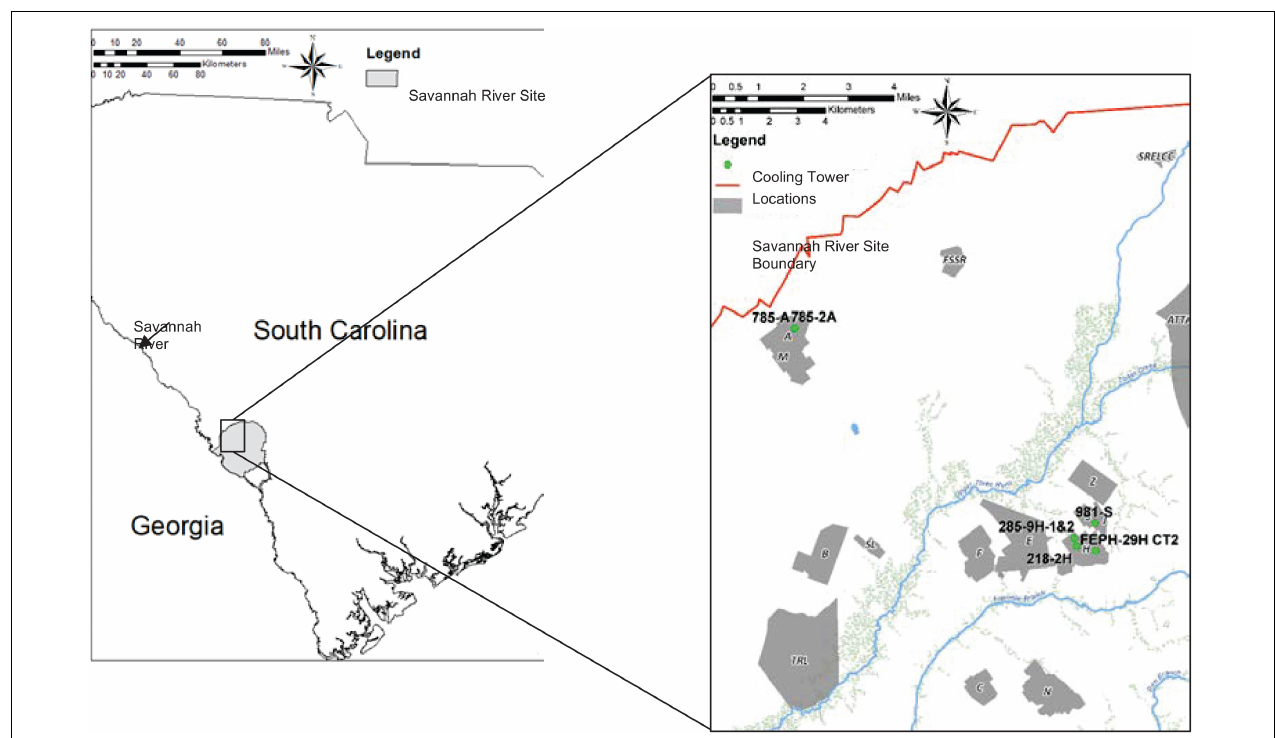
FIGURE 1 | Geographical distribution of cooling towers 785-A/785-2A, 285-9H-1&2, 218-2H, FEPH-29H CT2, and 981-S relative to the Savannah River Site in South